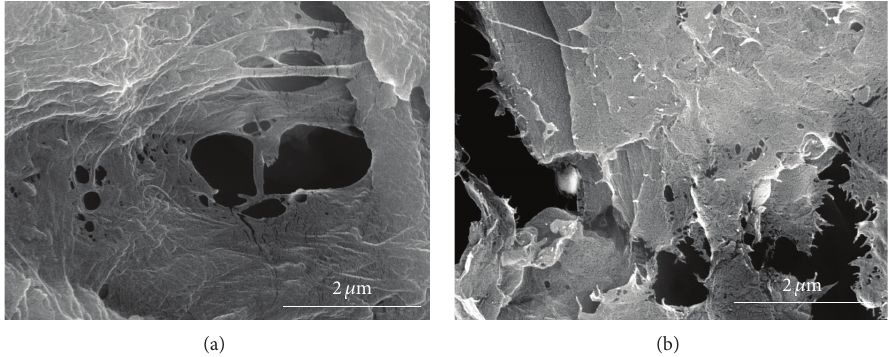
Figure 3: SEM micrographs of the (a) hemp fibres (CNF-F), and (b) hemp shives (CNF-S).